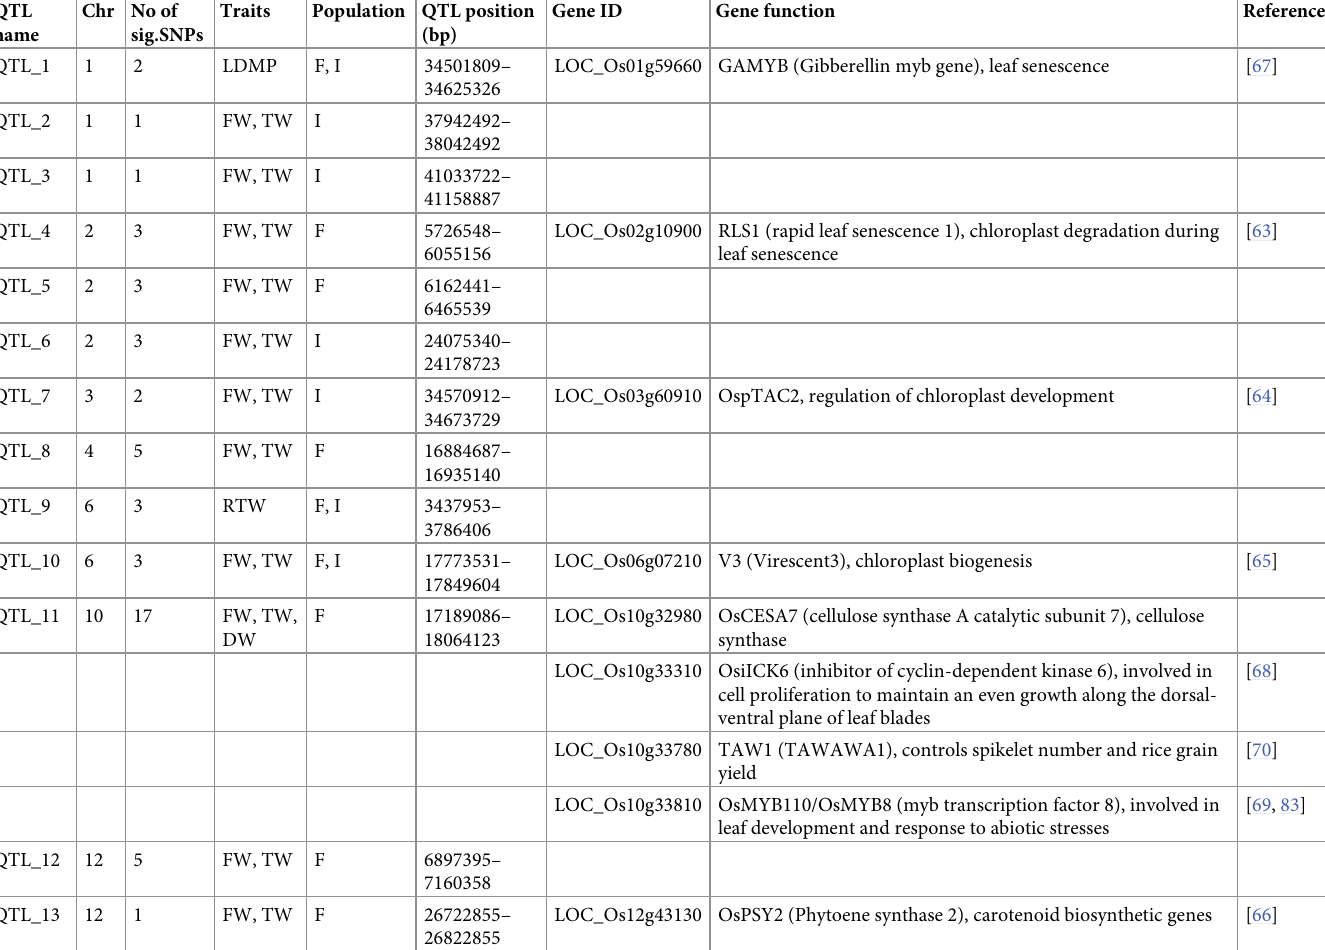
Table 3. Candidate genes underlying the identified